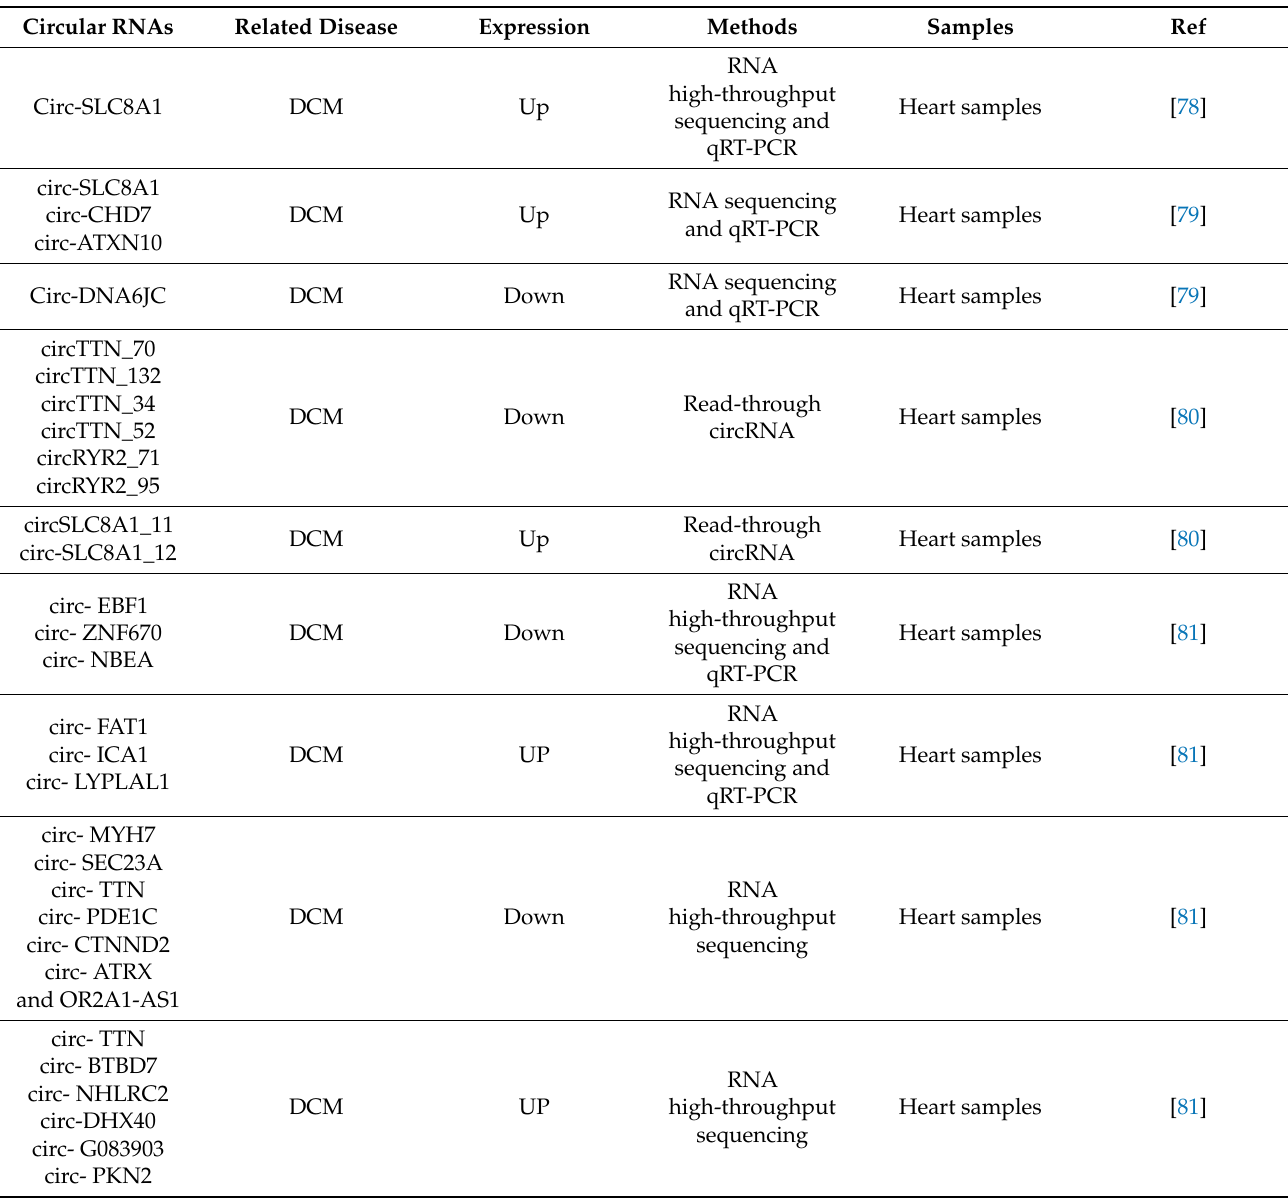
Table 1. The circular RNAs involved in dilated cardiomyopathy. Circular RNAs Related